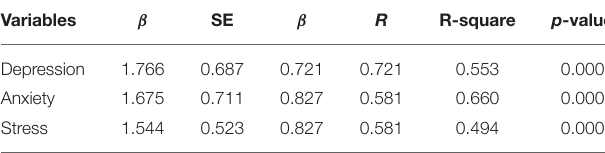
TABLE 9 | Fear of COVID-19 as the predictor of emotional distress (depression, anxiety, and stress) in nurses ( N = 500).